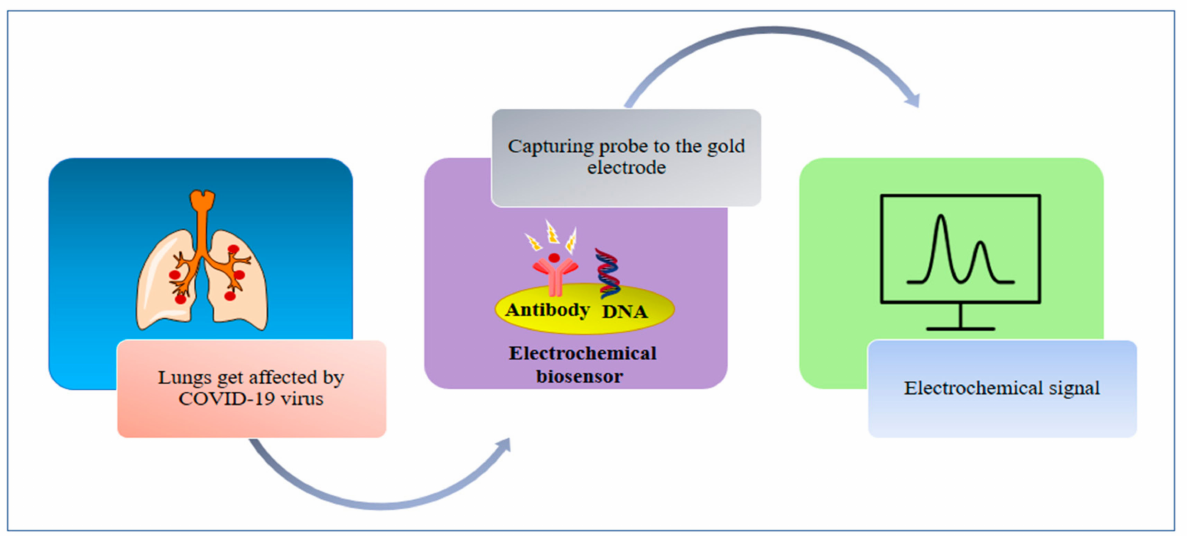
Figure 8. A schematic of the mechanism of electrochemical